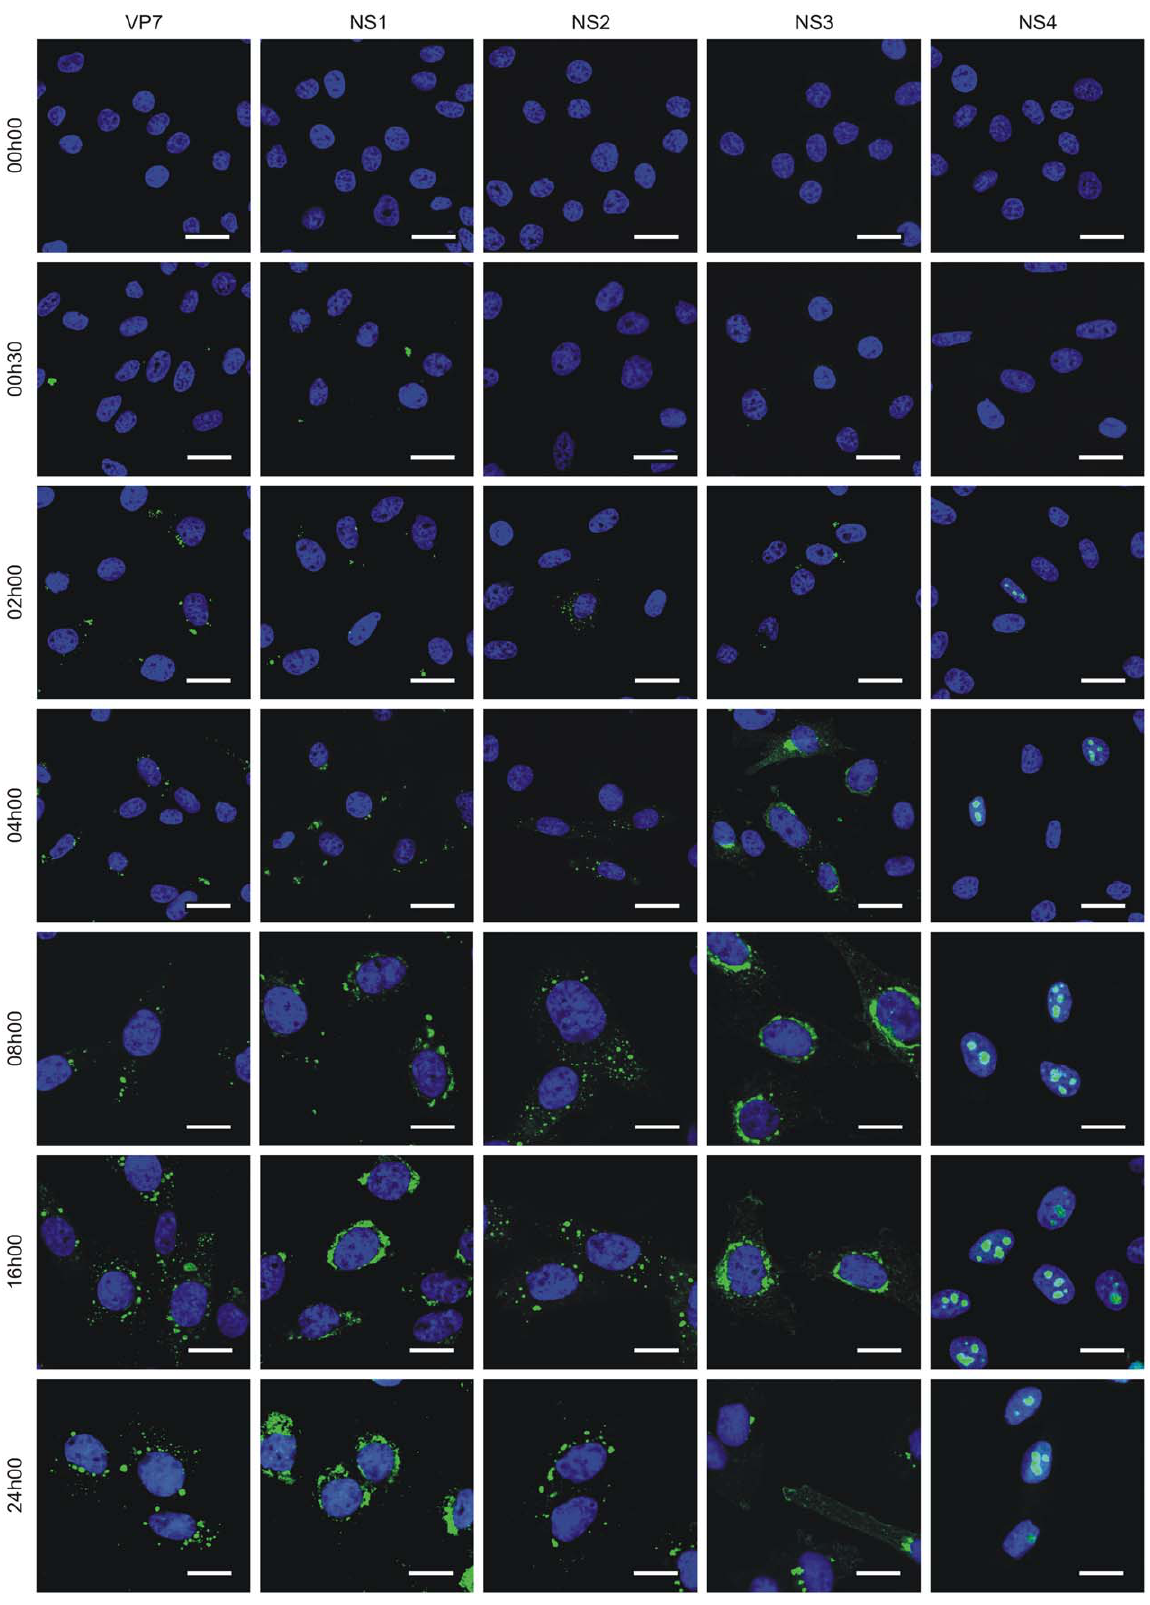
Figure 3. NS4 expression profile. Confocal microscopy of BFAE cells infected with BTV-1 at a MOI of 1.5. Cells were fixed before infection (0 h) and at 0 h30, 2 h, 4 h, 8 h, 16 h and 24 h post-infection and processed for immunofluorescence using antibodies against VP7, NS1, NS2, NS3 and NS4 with an Alexa Fluor 488 secondary antibody as described in the Materials and Methods. Scale bars correspond to 21.16 m m for 0 h to 4 h post- infection panels, and 13.6 m m for 8 h to 24 h post-infection panels. doi:10.1371/journal.ppat.1002477.g003 PLoS Pathogens |